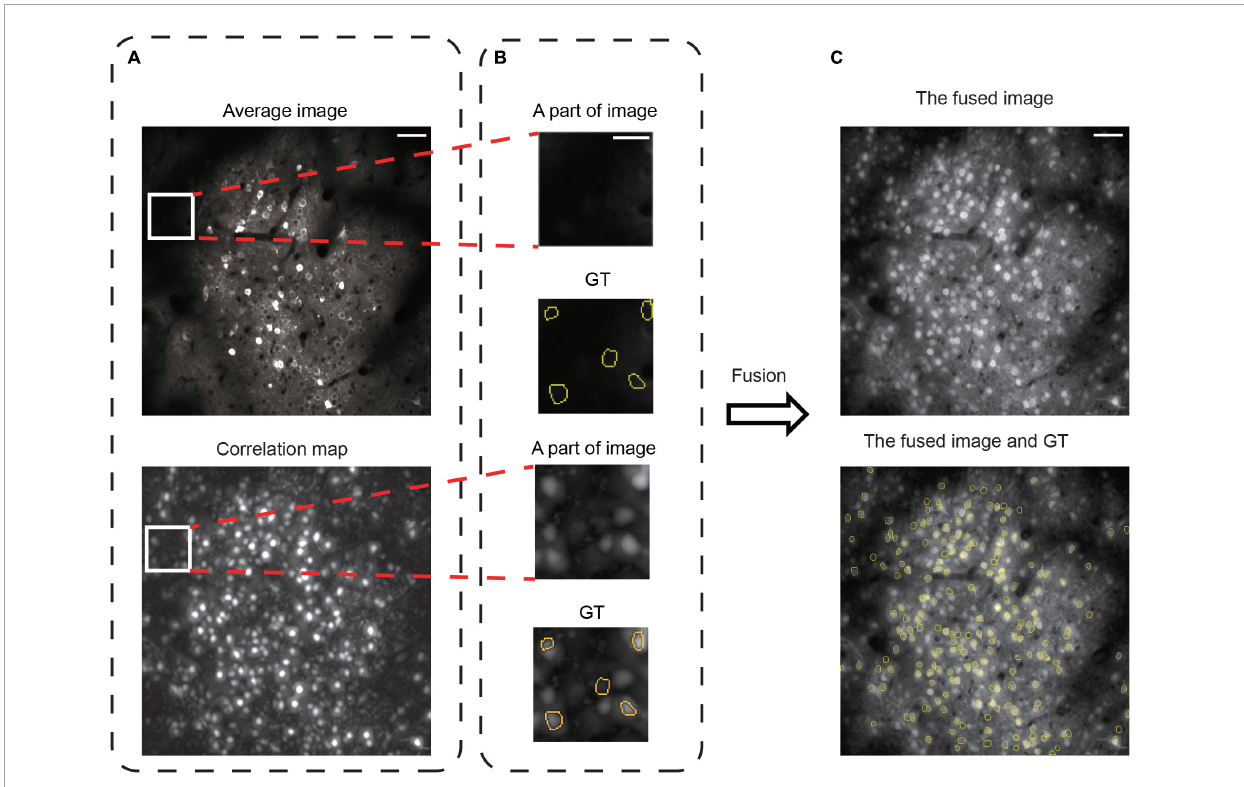
FIGURE3 Image fusion to improve spatiotemporal information representation. (A) The images are the average image and correlation map over the recording of one dataset, 02.00 test, from Neurofinder data. Scale bars, 50 µ m. (B) Some invisible, sparsely firing neurons are in the average image, and the correlation map can make these neurons visible. The GT is from STNeuroNet. The yellow outlines indicate the GT neurons. Scale bars, 20 µ m. (C) The average image and the correlation map were fused and supplemented with the spatiotemporal information of the 2D image. The GT is from STNeuroNet. The yellow outlines indicate the GT neurons. Scale bars, 50 µ m.